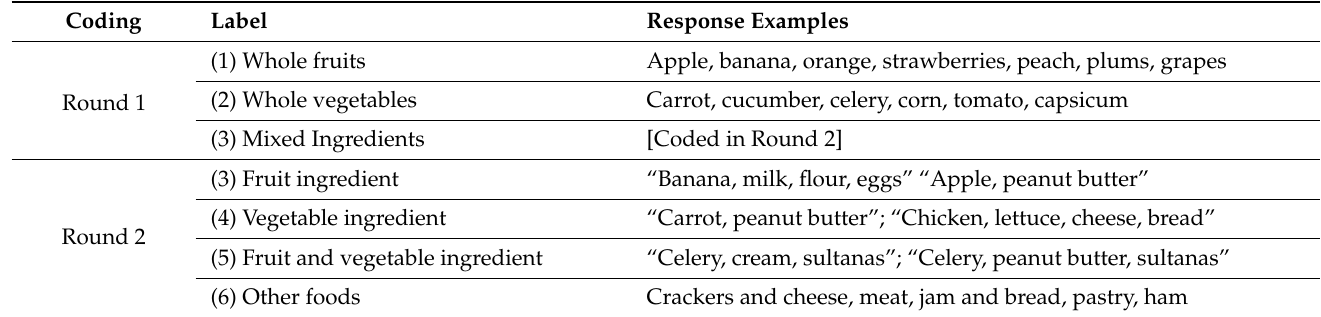
Table 2. Coding of ingredients listed in children’s’ descriptions of healthy snacks.